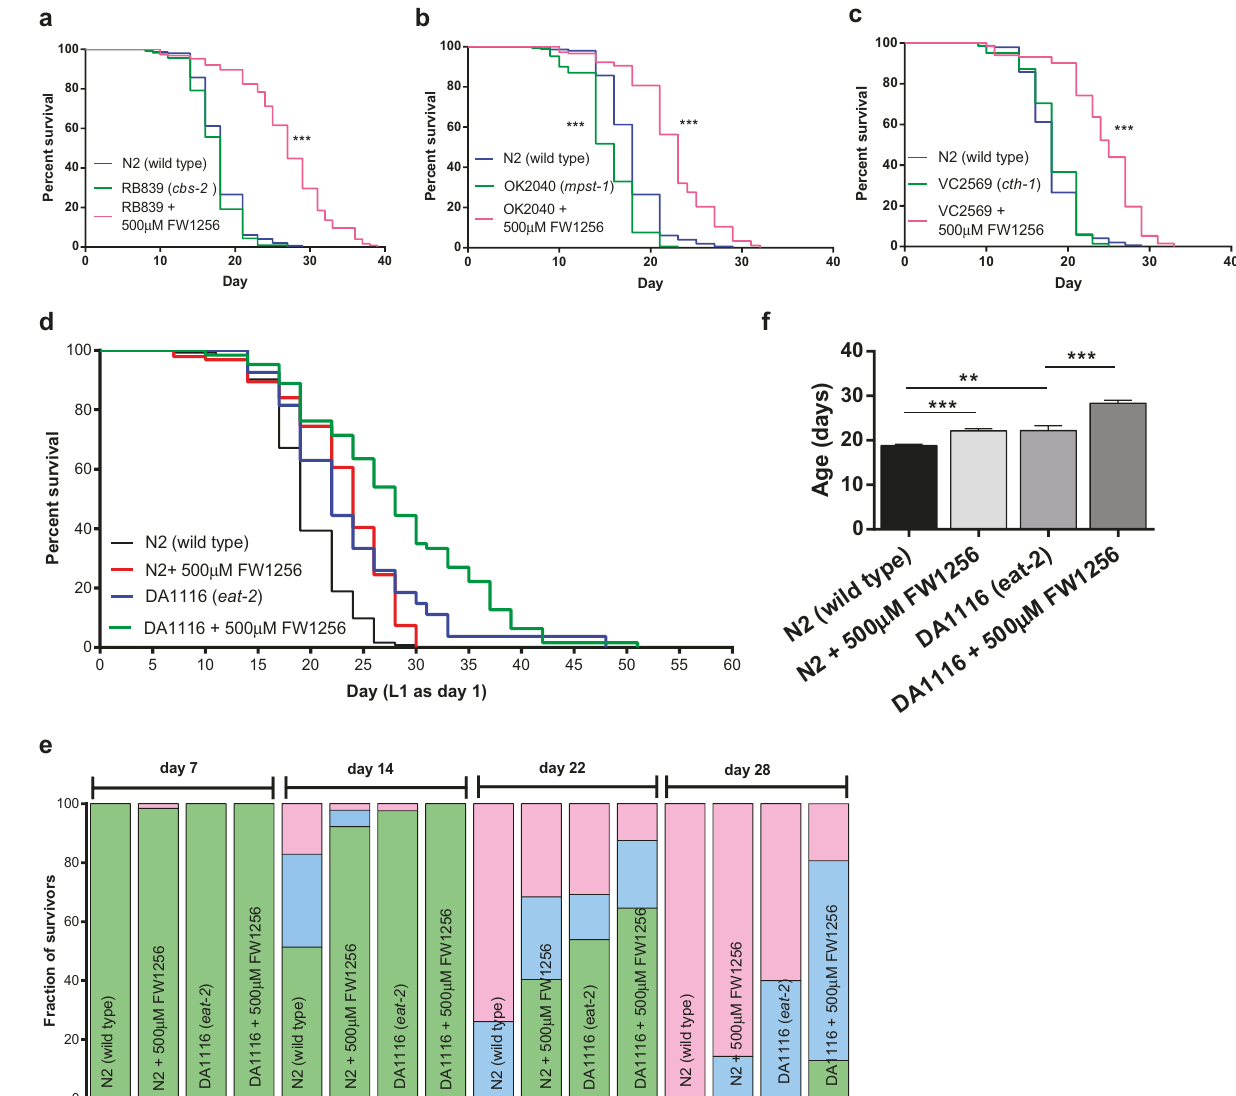
Fig. 3 FW1256 not only bene fi ts lifespans of H 2 S mutants and eat-2 mutants, but also promotes health. a – c Comparison of lifespans in WT C. elegans , H 2 S mutants and H 2 S mutants exposed to FW1256 (500 µM) (data show log-rank tests, *** p < 0.001). a RB839, cbs-2 mutants, n = 115-147 animals, b OK2040, mpst-1 mutants, n = 147 – 181 animals, c VC2569, cth-1 mutants, n = 132 – 147 animals. d Effect of FW1256 (500 µM) on lifespans of WT and eat-2 mutants, n = 27 – 122 animals per condition. e Mobility status of surviving nematodes at different ages, n = 27 – 122 animals per condition. Generally, class A nematodes moved constantly, class B nematodes moved only when prodded while